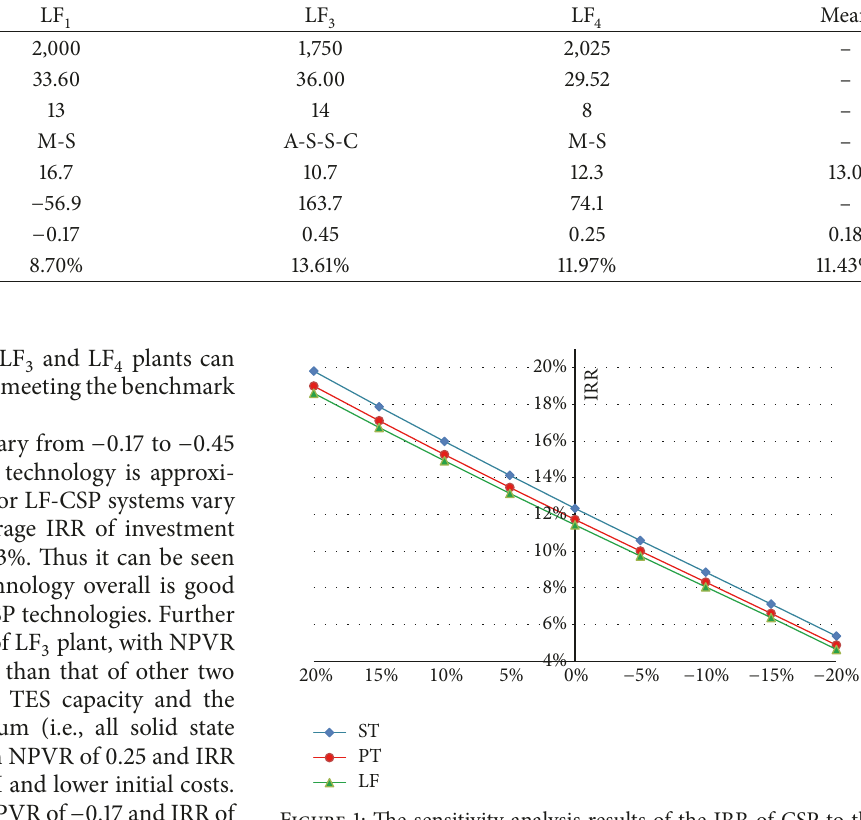
Figure 1: The sensitivity analysis results of the IRR of CSP to the annual electricity